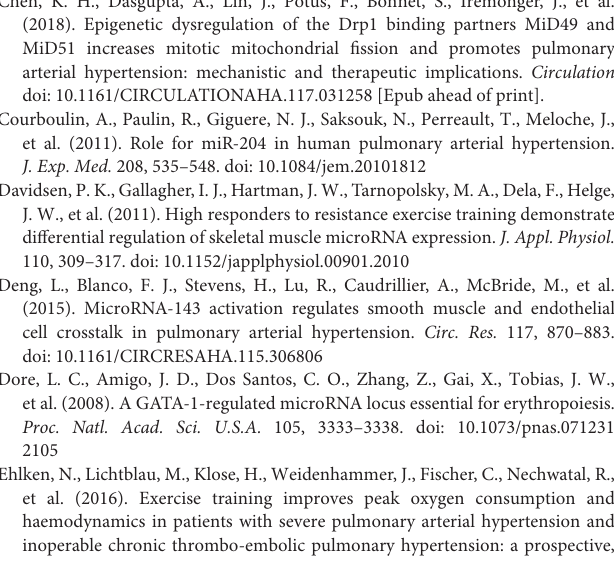
FIGURE S1 | Hierarchical clustering of serum miRNA levels determined relative to synthetic spike RNA from samples obtained before (B) or after (A) exercise intervention. (a) Full pilot study miRNA panel. Note that miR-22-3p and miR-21-5p are in clusters distinct from miR-451a. Also note that samples from a single donor are listed together (box) but not clustered together. (b) Selected miRNAs. Note that miR-22-3p and miR-21-5p are clustered together apart from miR-451a. Note that none of the paired samples are listed together. FIGURE S2 | Hierarchical clustering of serum or plasma miRNA levels determined relative to synthetic spike RNA from n = 52 paired samples, total n = 104. The samples were obtained before (B) or after (A) exercise intervention at the University of Heidelberg (HD), or following placebo (P) or oxygen (O) intervention at the University of Zurich (ZH), respectively. Samples from 46 donors clustered apart; the samples from 6 donors were either listed or clustered together and are indicated